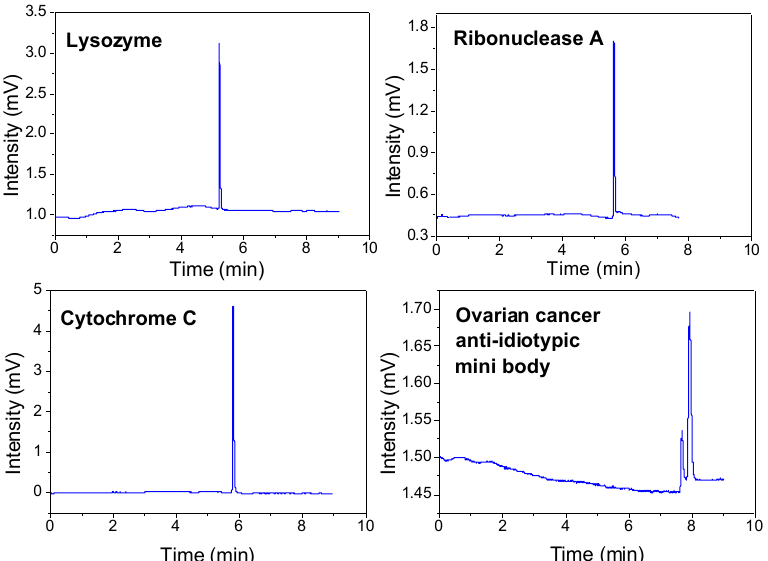
Figure 6. The pCEC separation of 4 proteins with 300 nm C18-bonded silica particles. The experimen- tal conditions were as follows: column: 100 µ m i.d. × 100/300 mm (effective/total length); mobile phase: acetonitrile–water (50:50, v / v ); 0.1% FA; pH = 2.3; applied voltage = 10 kV (lysozyme, ribonu- clease A, and cytochrome C)/8 kV (ovarian cancer anti-idiotypic mini body); pressure = 12.5 MPa; and split ratios of 1000:1. The theoretical plates results were as follows: lysozyme, 139,152; ribonucle- ase A, 98,973; cytochrome C, 101,156; impurity in ovarian cancer anti-idiotypic, 65,100; and ovarian cancer anti-idiotypic, 45,100.